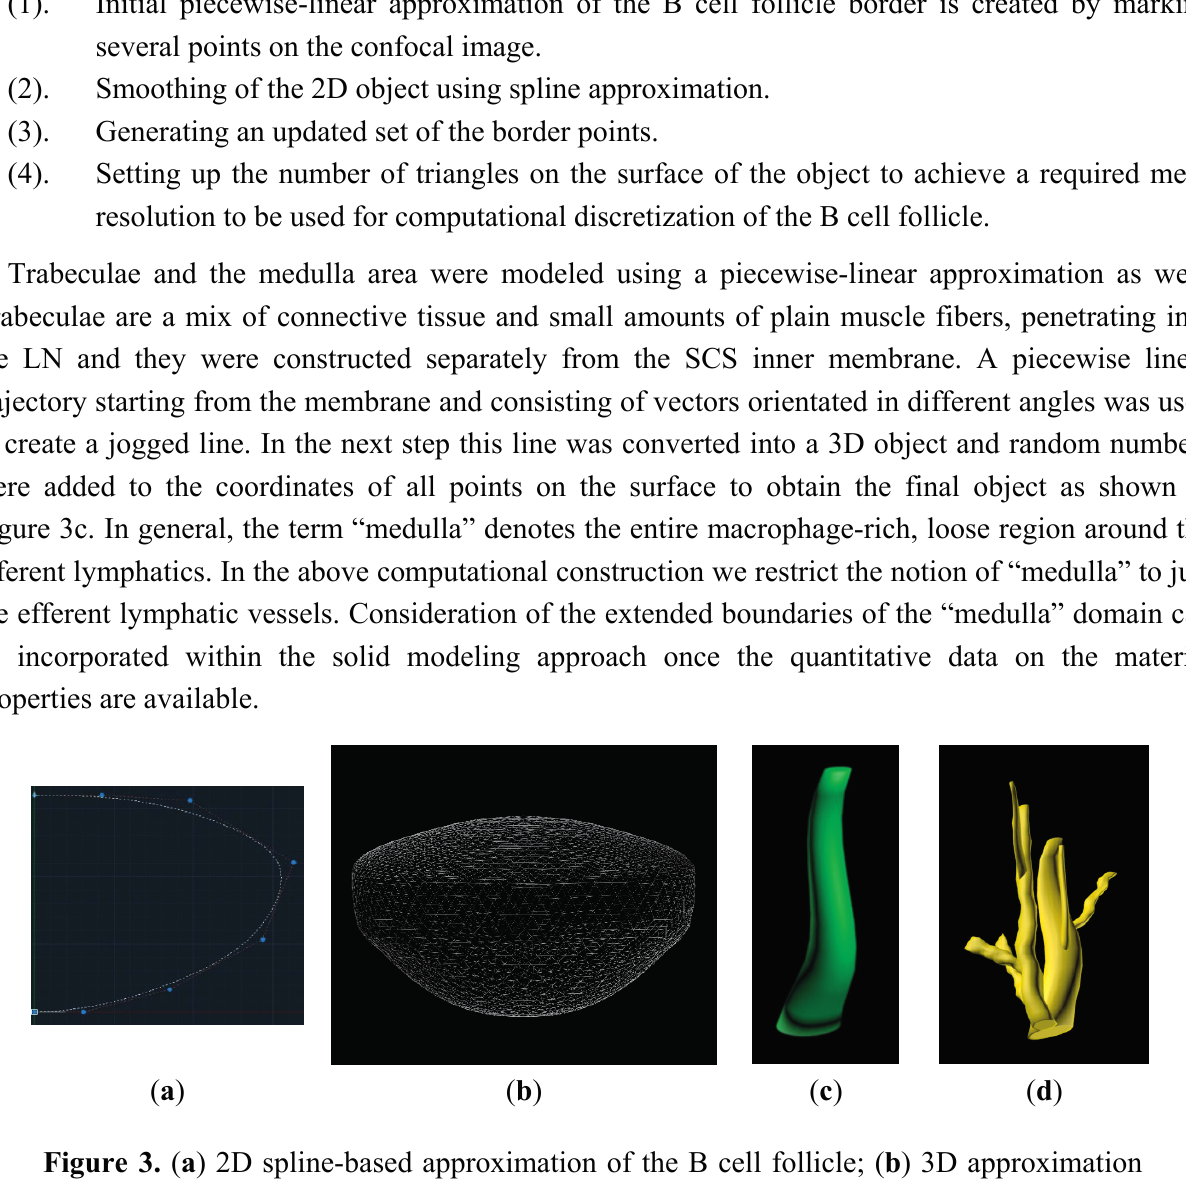
Figure 3. ( a ) 2D spline-based approximation of the B cell follicle; ( b ) 3D approximation of the B cell follicle; ( c ) 3D solid model of the trabecular sinus; ( d ) 3D solid model of the